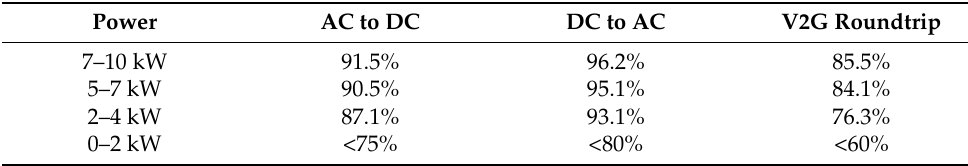
Table 4. Results out of the efficiency